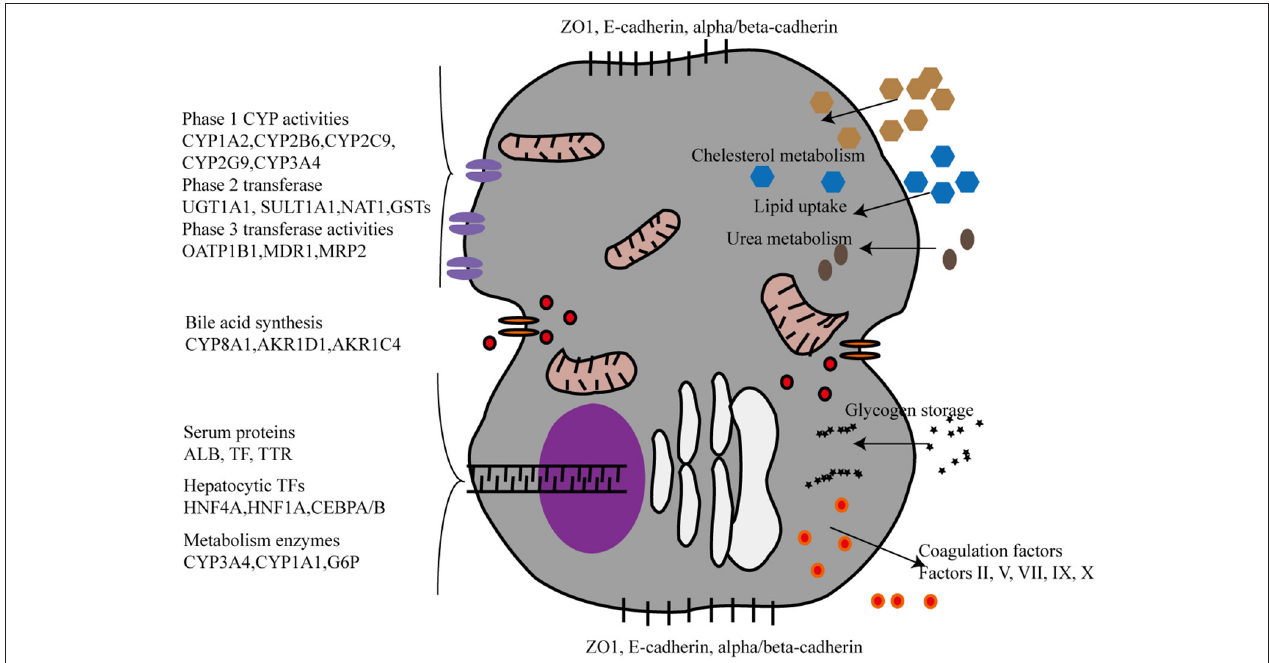
FIGURE 2 | The phenotypic characterization of Hepatocyte-like cells derived from iPSCs. CYP, CYPs cytochromes P450; UGT, UDP glucuronosyltransferase. SULT1A1, Sulfotransferase Family 1A Member 1; NAT1, N-Acetyltransferase 1; GSTs, Glutathione S-Transferase; OATP, organic anion-transporting polypeptide; MDR, Multiple drug resistance; MRP2:multidrug resistance protein 2; AKR1D1, aldo-keto reductase family 1 member D1, AKR1C4, aldo-keto reductase family 1 member C4, TTR:Transthyretin, TP, Total protein, ALB, Albumin, HNF, Hepatocyte nuclear factor, CEBPA/B, CCAAT Enhancer Binding Protein Alpha/Beta, G6P,